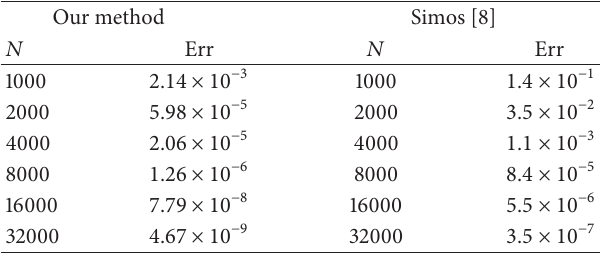
Table 1: Results, with 𝜔 = 10 , for Example 1.